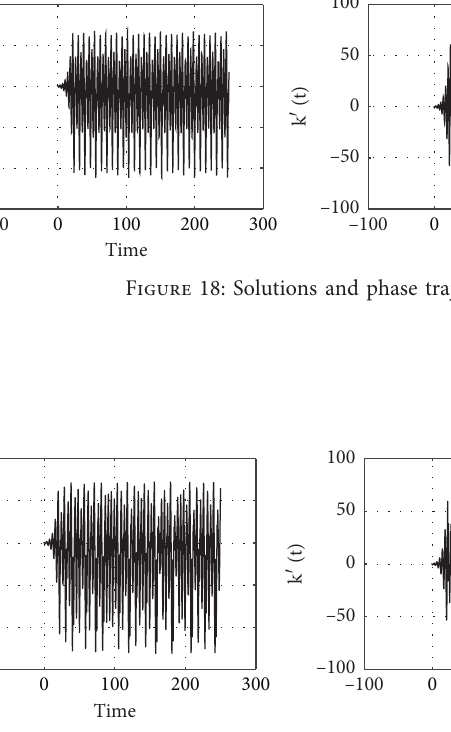
Figure 19: Solutions and phase trajectories at a � 0.125, q � 1, and τ � 1.45.